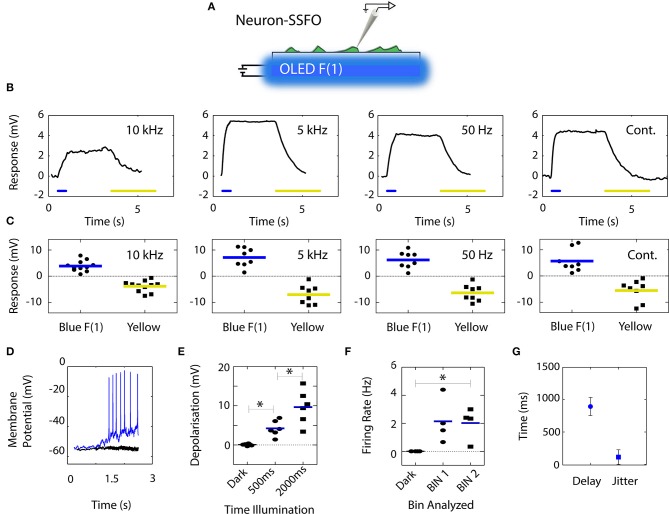
Depolarization of SSFO-expressing neurons by blue OLED illumination at various pulse rates. (A) Neurons were transfected with SSFO, stimulated by a blue OLED, and recorded in current-clamp configuration. (B) Representative responses from individual neurons. At all tested frequencies, 500 ms of blue light stimulation was sufficient to depolarize the neurons, leading to sustained activation that extended beyond the pulse stimulus; activation could be fully reversed by yellow light stimulation. (C) Individual neurons (symbols) and mean (colored lines) amplitudes of blue light-induced depolarization in response to 500 ms stimuli and yellow light-induced hyperpolarization in SSFO-expressing neurons (n = 8–11). (D) Sample recording from a mature neuron transfected with SSFO (blue trace) and illuminated for 2 s that successfully reached the firing threshold. The black trace represents the response of a control mock-transfected neuron. (E) Effects of stimulus length on the extent of depolarization, excluding action potentials, of SSFO-expressing neurons in response to 2 s stimuli (symbols and lines represent individual neurons and the mean, respectively). Depolarization increased significantly with the time of illumination (n = 6). (F) The firing rate of SSFO-expressing neurons increased significantly during prolonged illumination. The individual values (symbols) and mean (line) firing are shown for 1 s bins before (dark) and during the blue light stimulus (n = 4). (G) Quantification of the delay and jitter of action potential firing based on the first spike per stimulus calculated across all recorded neurons.